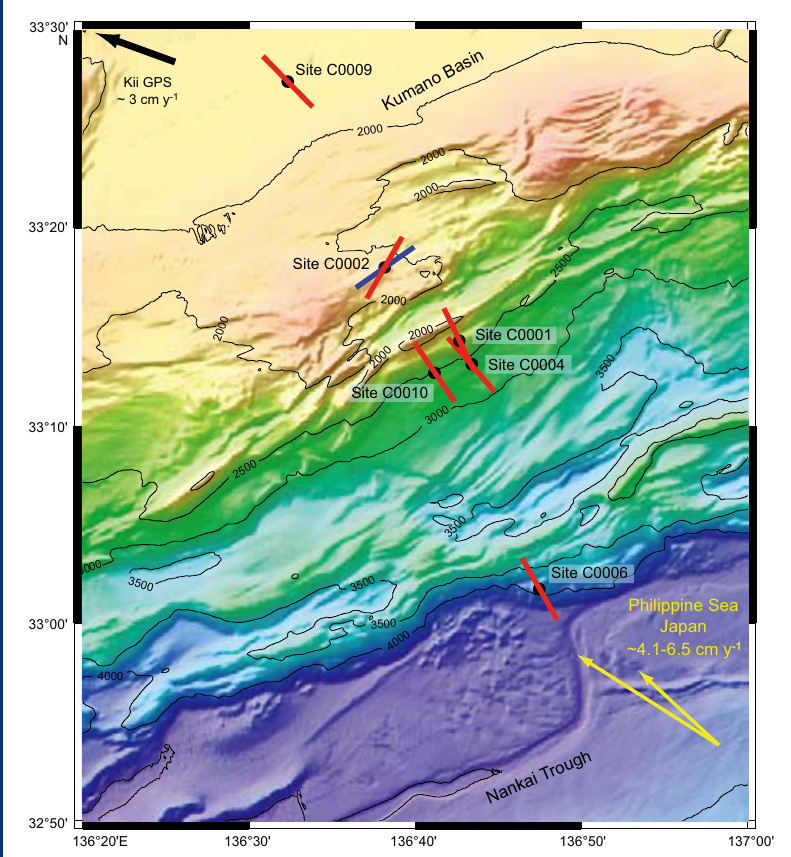
Figure 6. Map showing orientations of maximum horizontal stress inferred from borehole breakouts (see also Kinoshita et al., 2009a). At Site C0002, red line = orientation in forearc basin sediments, blue line = orientation in underlying accretionary prism. Yellow arrows indicate range of suggested convergence rates between the two plates and black arrow indicates GPS-constrained displacement on the Kii peninsula (Seno et al., 1993; Miyazaki and Heki, 2001; Heki,